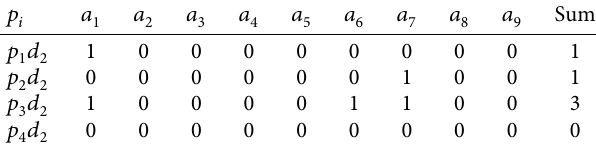
Table 10: Tabular representation of Λ